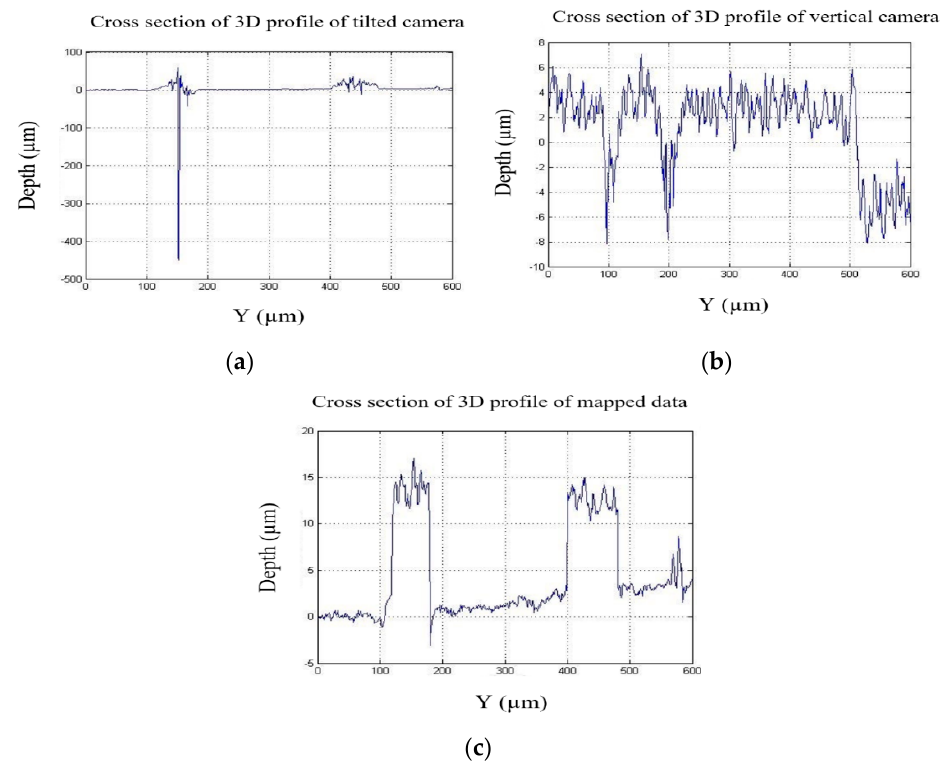
Figure 15. Cross-section profile measured on IC chip shown in Figure 14: ( a ) cross-section profile reconstructed from specular light components; ( b ) cross-section profile reconstructed from diffuse light components; ( c ) 3-D cross-section surface mapped by proposed mapping algorithm.